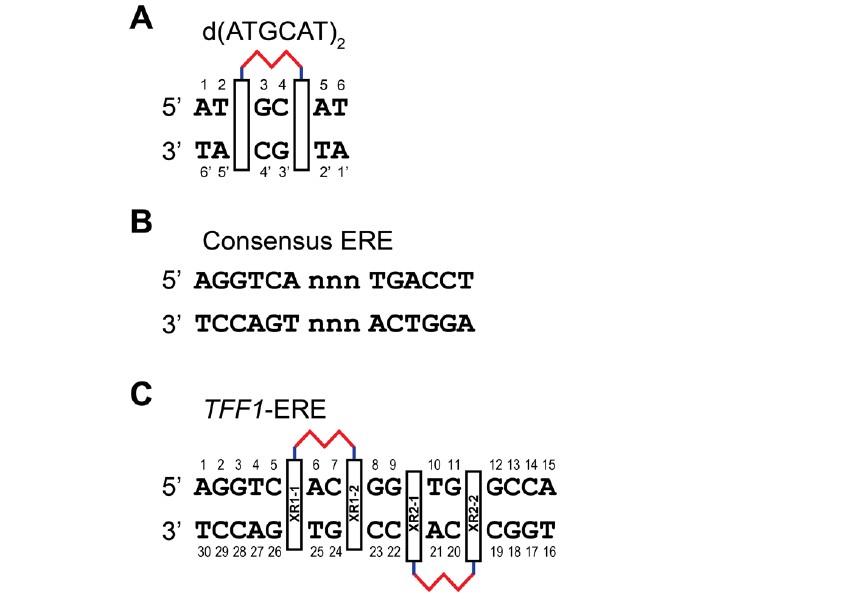
Figure 2. ( A ) XR5944 preferred binding site of palindromic DNA sequence d(ATGCAT) 2 . Two chromophores intercalate at a 5 ′ -TpG / 5 ′ -CpA site, enveloping two base pairs. ( B ) Consensus ERE sequence with variable “nnn” trinucleotide spacer. ( C ) Two binding sites of XR5944 to the naturally occurring TFF1-ERE DNA sequence.